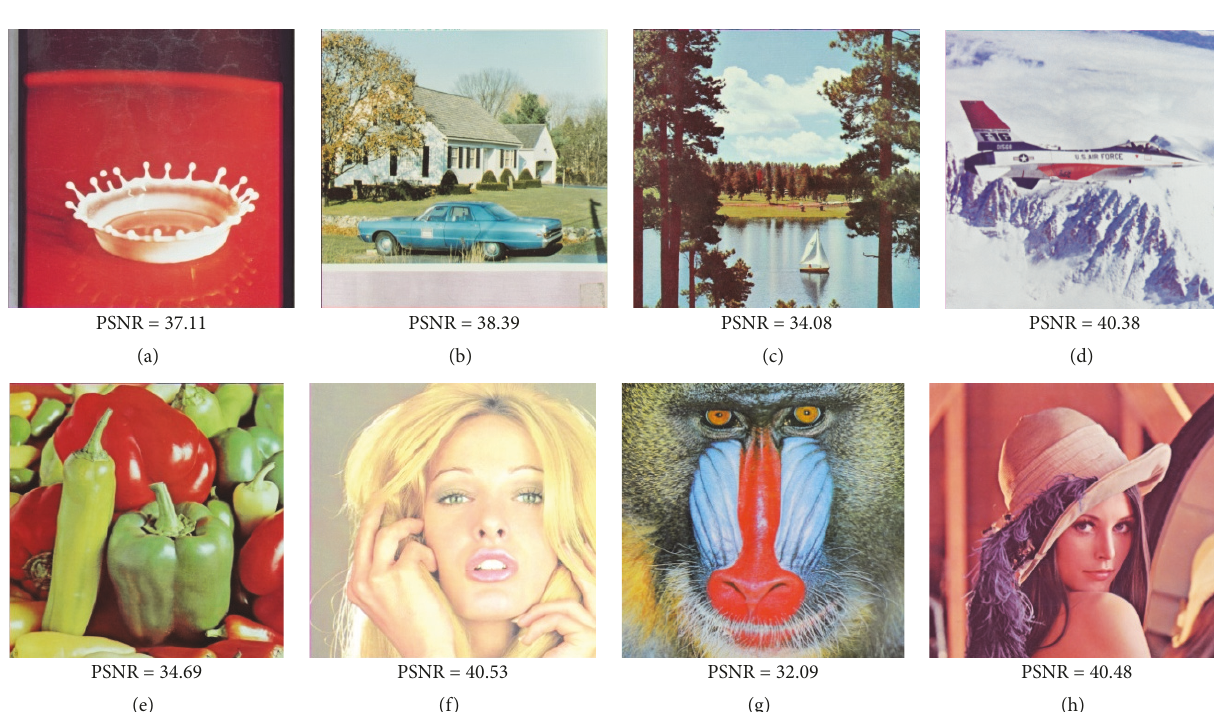
Figure 6: Stego images of proposed type 2 (t=4, range table